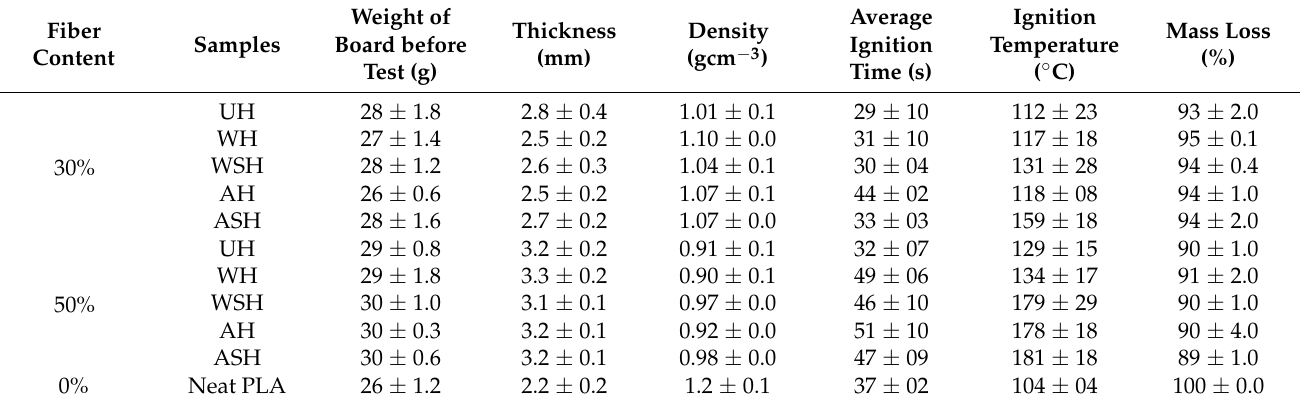
Table 6. Specimen properties, mass loss and ignition time and